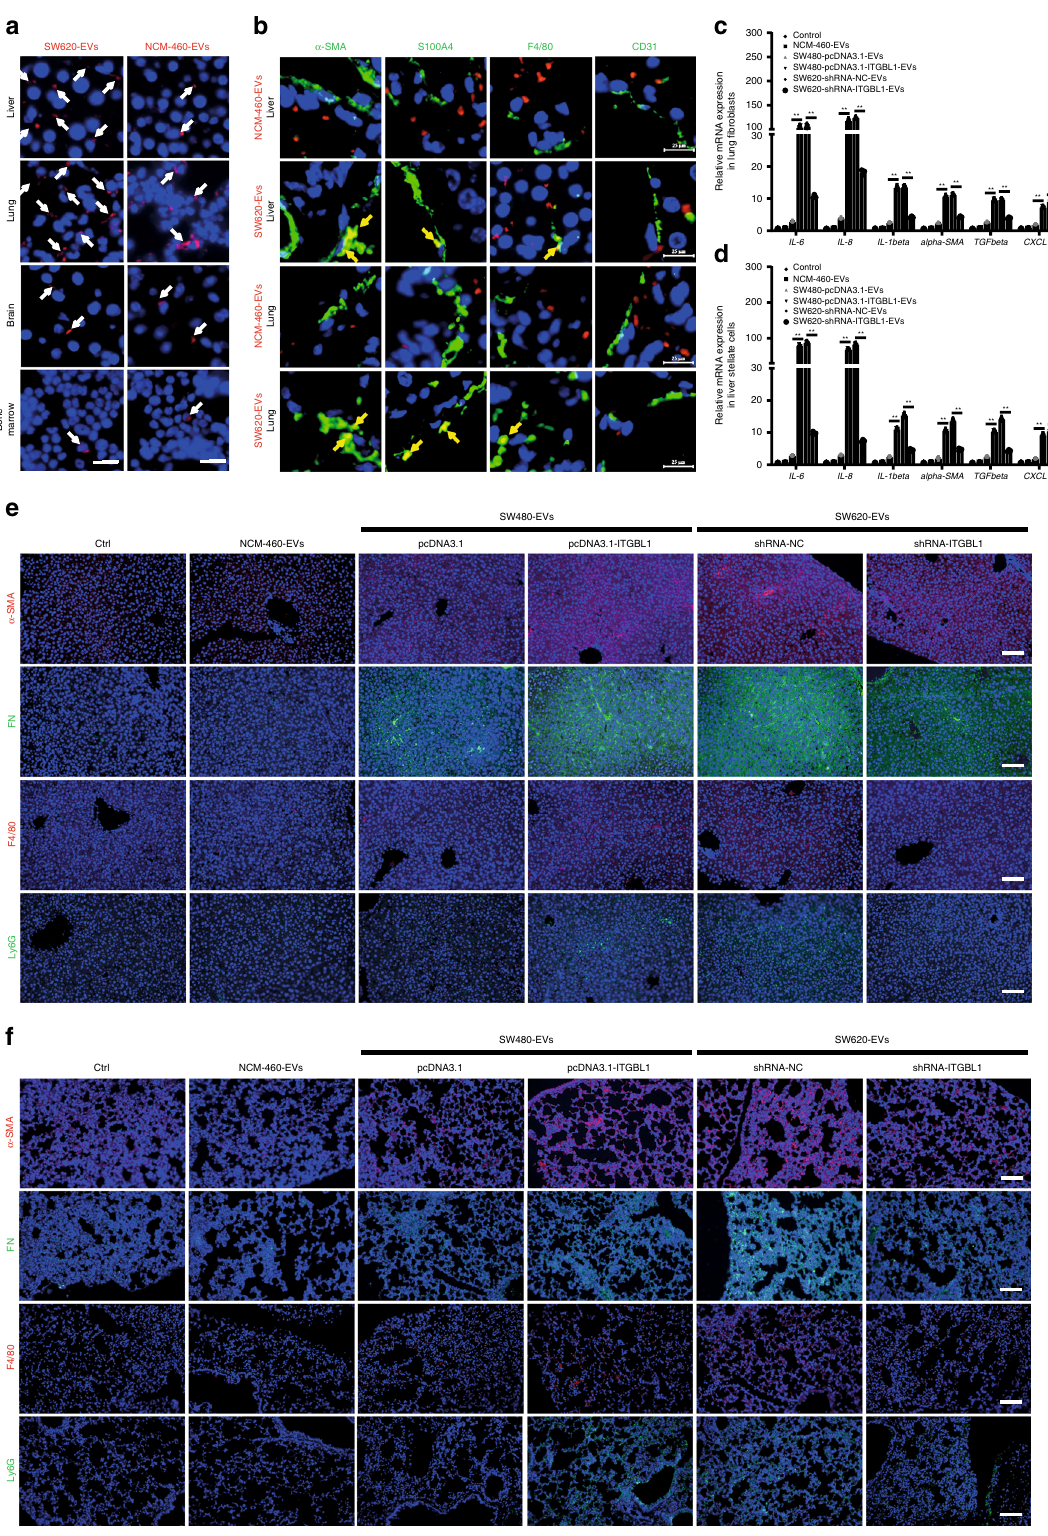
decreased ITGBL1-induced phosphorylation of inhibitor of nuclear factor kappa-B kinase alpha/beta (IKK α / β ), and phosphorylated NF- κ B, but increased I κ B α . The relative luciferase activity of NF- κ B also con fi rmed the regulatory effect of TNFAIP3 on the NF- κ B signaling pathway (Fig. 6k). These results demonstrated that the fi broblasts